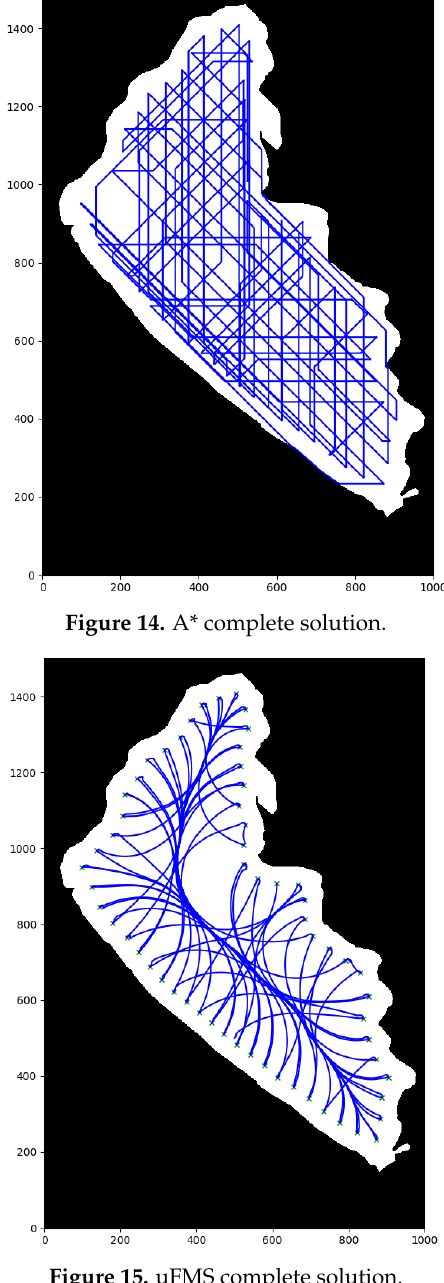
Figure 15. uFMS complete